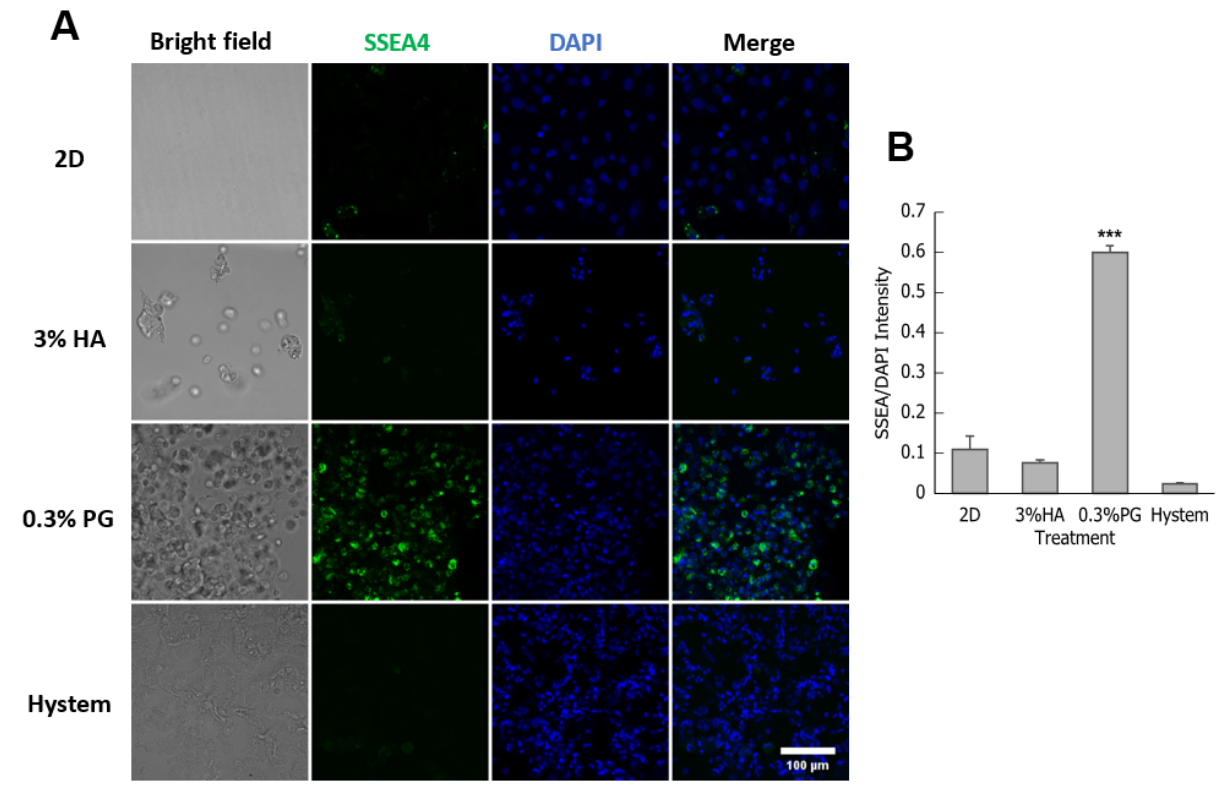
Figure 2. Encapsulated and 2D-plated hADMSCs with stage-specific embryonic antigen-4 (SSEA4) immunostaining and nuclear staining (DAPI). ( A ). Confocal images of cells, scale bar = 100µm; ( B ). Fluorescence intensity, shown as SSEA4/DAPI. Results are shown as mean ± SEM, *** p < 0.001. In addition, immunolabeling for cytoskeleton filaments, F-actin and G-actin, was performed on these hADMSCs. We found that though the release of actin tension, reflected by a reduction in F-actin stress fiber, existed in all 3D-encapsulated hADMSCs, actin organization is slightly different in hADMSCs in different hydrogels (Figure 3A). In 3% HA, F-actin formed various small clusters dispersing within and on the edge of hADMSCs. Similar F-actin distribution was observed in hADMSCs treated with 0.3% PGmatrix as 3% HA, except F-actin clusters were larger in PGmatrix-encapsulated hADMSCs. In contrast, F-actin in Hystem-encapsulated hADMSCs formed bright cortical filaments to support cell shape, with the rest relatively evenly distributed inside the cells. G-actin in these groups followed similar patterns as F-actin, with PGmatrix group having the highest level of actin agglomeration. Different from Zhou et al. [19], we observed bright F-actin clusters when F-actin stress fiber reduced in 3D. Assessment of F-actin fluorescence intensity showed no difference between the groups (Figure 3B), indicates changes in F-actin organization, not F-actin protein production.